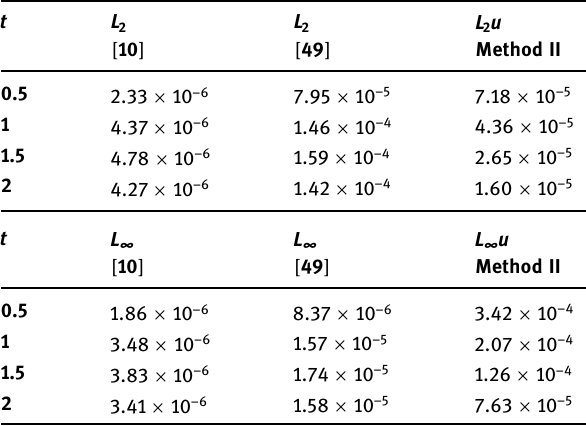
Table 6: Comparison of error at di ff erent time levels with = N 701 , = α 10 , = β 15 ,